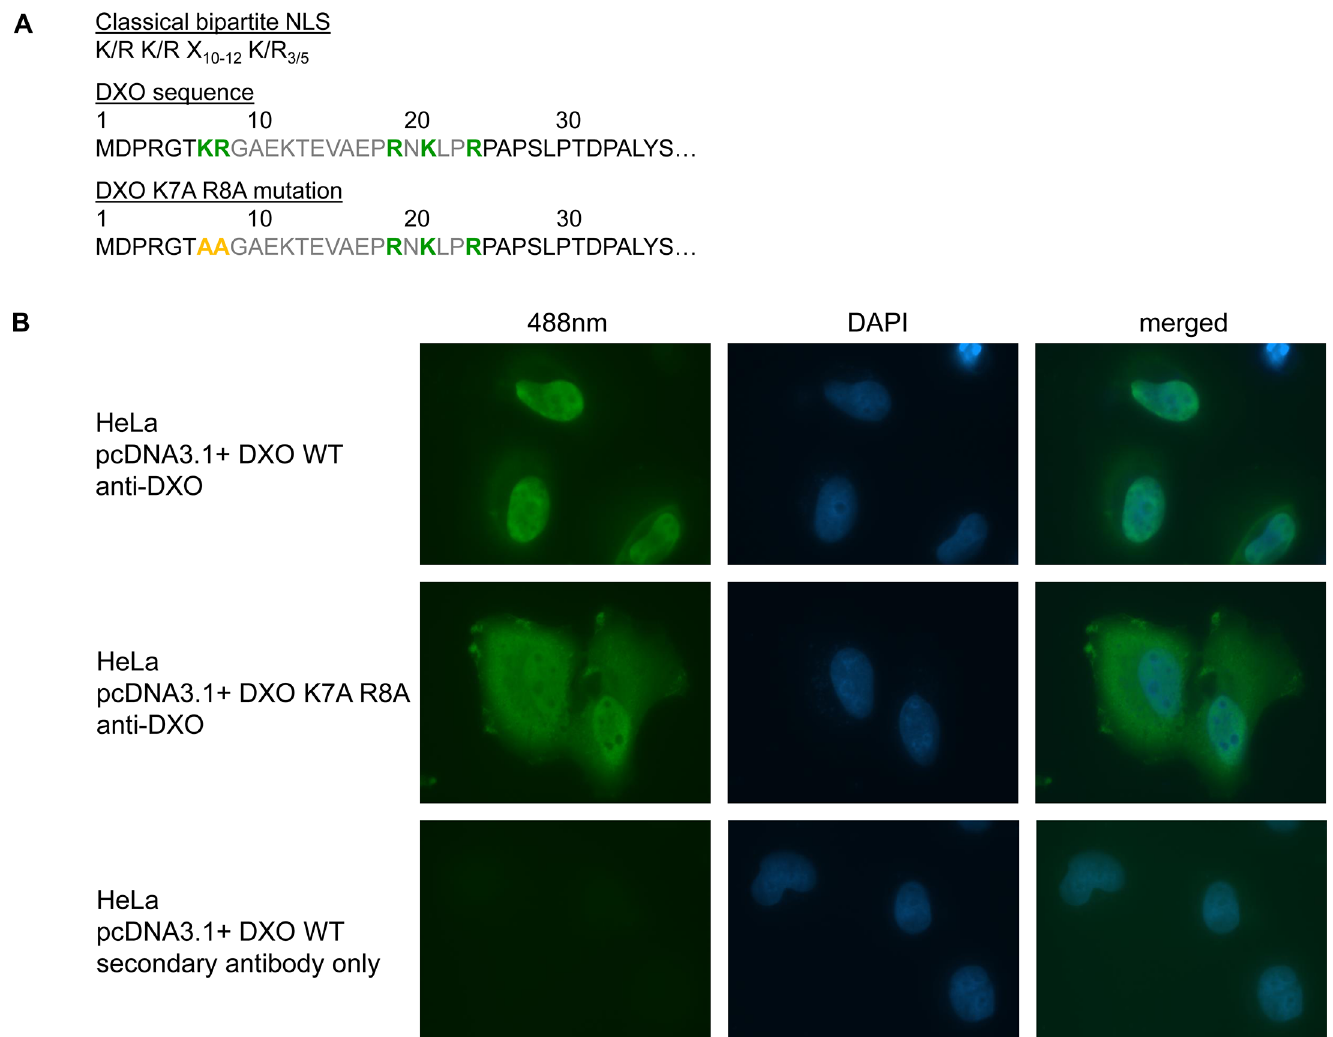
Fig 5. DXO contains a functional NLS as shown by site-directed mutagenesis and immunofluorescence. (A) A schematic representation of a classical bipartite NLS consensus sequence and the corresponding sequence at the N-terminal end of DXO. (B) HeLa cells were transfected with pcDNA3.1+/DXO and pcDNA3.1 +/DXO-K7A-R8A (mutations in the NLS) using Lipofectamine 2000. DXO localization was monitored 48 hours post-transfection by immunofluorescence using a rabbit polyclonal DXO antibody and a polyclonal anti-rabbit antibody coupled to Alexa Fluor 488. Fluorescent images were gathered using an epifluorescence microscope with a 60x objective. Exposure times were identical in all three